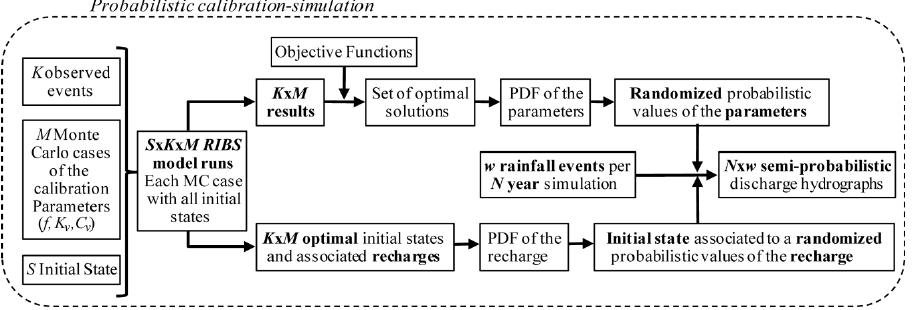
Figure 6. Probabilistic calibration–simulation process.